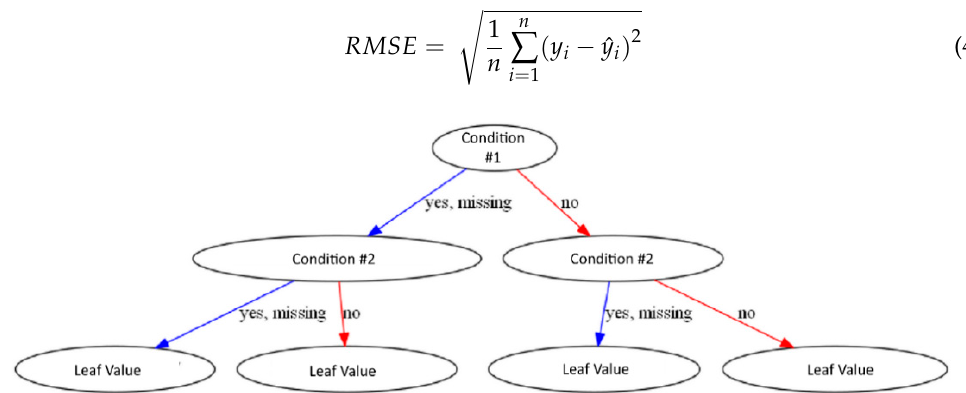
Figure 3. Example eXtreme Gradient Boosting (XGB) XGBoost regression tree composed of a series of conditional statements that test each observation with successive branches and leaf nodes deciding the predicted split value of a target variable.